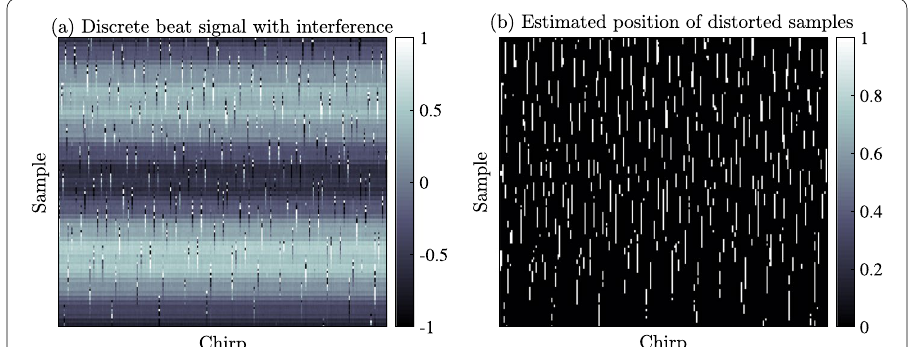
Fig. 3 a An example discrete beat signal with interference; b The positions of the distorted samples detected by the Laplacian filter with iterative adaptive thresholding are indicated by 1. For an intuitive visualization, the amplitude of the measurement in ( a ) is normalized between